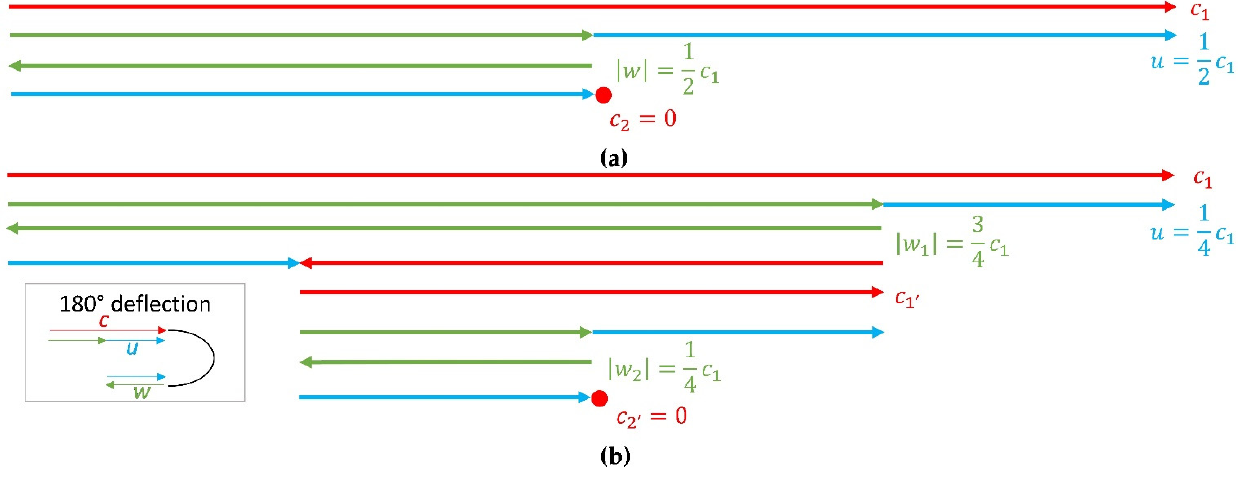
Figure 1. Comparison of velocity triangles: ( a ) ideal 180° deflecting impulse turbine; ( b ) ideal velocity compounded turbine with two velocity stages.